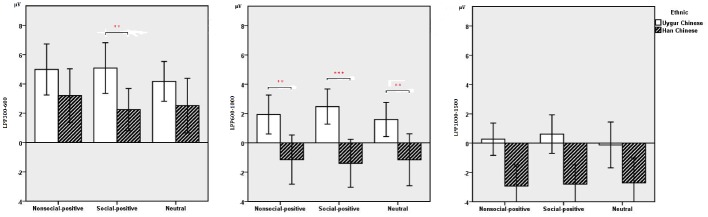
Average LPP amplitudes of non-social positive, social positive, and neutral stimuli in the time window of the early LPP (300–600 ms; Left), middle LPP (600–1,000 ms; Middle) and late LPP (1,000–1,500 ms; Right) between Han Chinese (n = 21) and Uygur Chinese (n = 21). Error bars represent ±2 standard errors. **p < 0.05, ***p < 0.001.